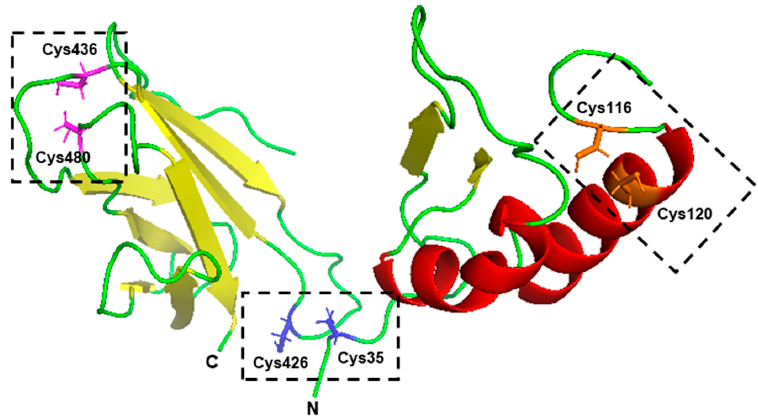
Figure 3. Site-directed mutagenesis to create Cys–Cys disulfide bonds that generated thermoresistance. The 3D structure of the triple-pair Cys mutant of A. amylolytica α -amylase was generated in silico, as described in Reference [116], and then subjected to homology-based I-TASSER modeling [117]. The modeling selected α -amylase (3BC9) of Halothermothrix orenii as a high “C-score” homology match among eight closest PDB templates (the other seven being 3BCF, 4JCL, 2DIJ, 2GJP, 6GXV, 4UZU, and 4JCL), independently confirming the previous studies [116]. The PDB structure, thus obtained, is displayed through PyMol (https://pymol.org, Schrödinger, LLC, USA). Each Cys pair, engaged in disulfide bonding and marked with a box, is shown as stick side chains and has a distinctive color: Cys35–Cys426 (blue), Cys116–Cys120 (orange), and Cys436–Cys480 (magenta). For the sake of clarity, portions of the structure and the disulfide bonds are not shown; moreover, no attempt was made to depict the proper rotamer of the side chains, and, therefore, the S atoms of a pair may not be directly facing each other in this representation. The N- and C-terminal directions are also indicated. The structural elements are color-coded: helix, red; strand, yellow; loop, green. A more detailed structure can be found in the original study [116].